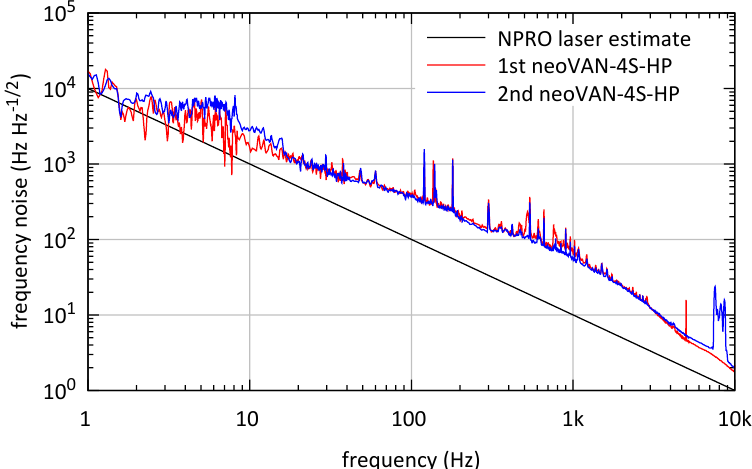
Figure 9. Frequency noise measurements of the beam amplified by the first and second neoVAN-4S-HP amplifier, respectively. Both curves are very close to each other and to the typical NPRO behavior, as